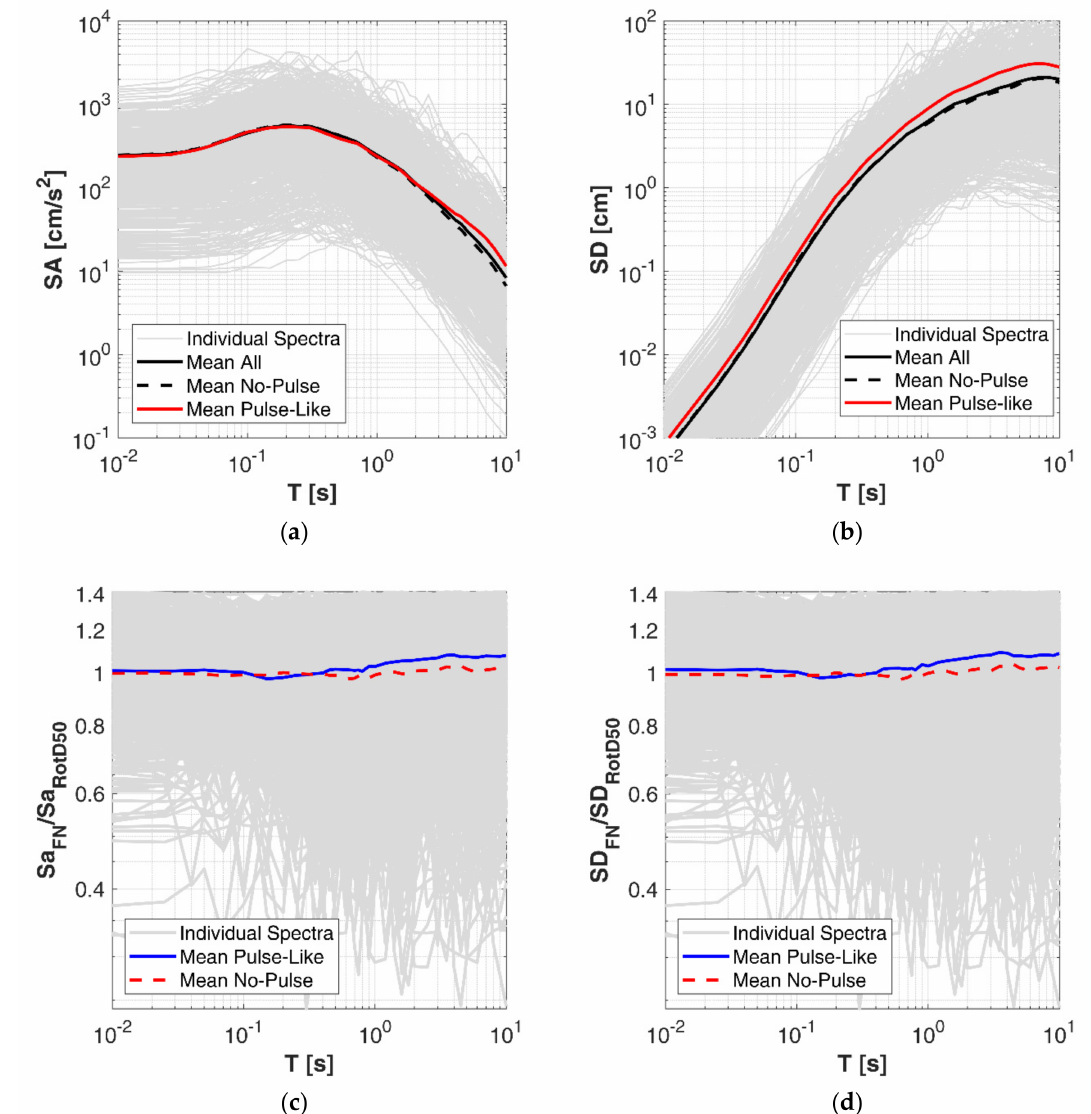
Figure 3. Average elastic 5%-damped acceleration response spectra acceleration (SA) as RotD50 ( a ) and average elastic displacement spectra SD ( b ) in log-log scale, for pulse-like and no-pulse records in NESS1. Ratio between RotD50 and fault normal (FN) spectral components for acceleration ( c ) and displacement ( d ) elastic response spectra. Thin gray lines indicate the individual spectra; solid-colored lines refer to the mean of pulse-like records; the dashed lines refer to no-pulse